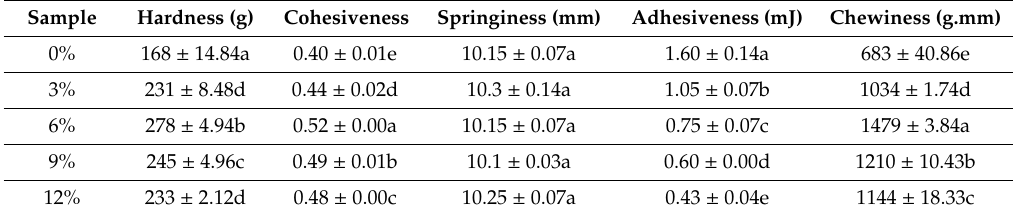
Table 4. TPA (texture profile analysis) properties of starch gels as a function of gum Cordia .